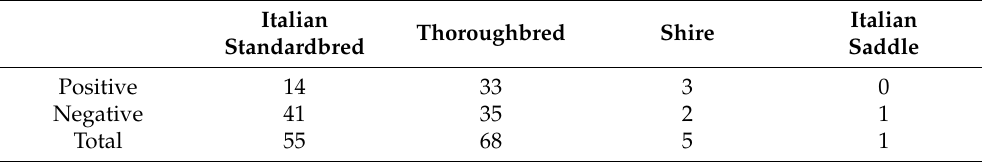
Table 3. EcPV2 genoprevalence in mares divided by breeds.